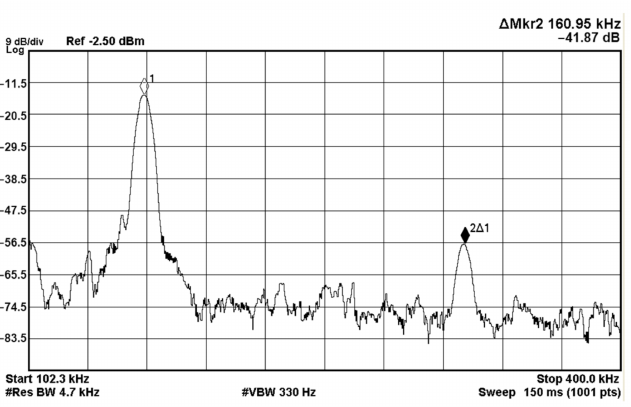
Figure 21. The frequency spectrum results of the VM fully uncoupled QSO at the V o2 output